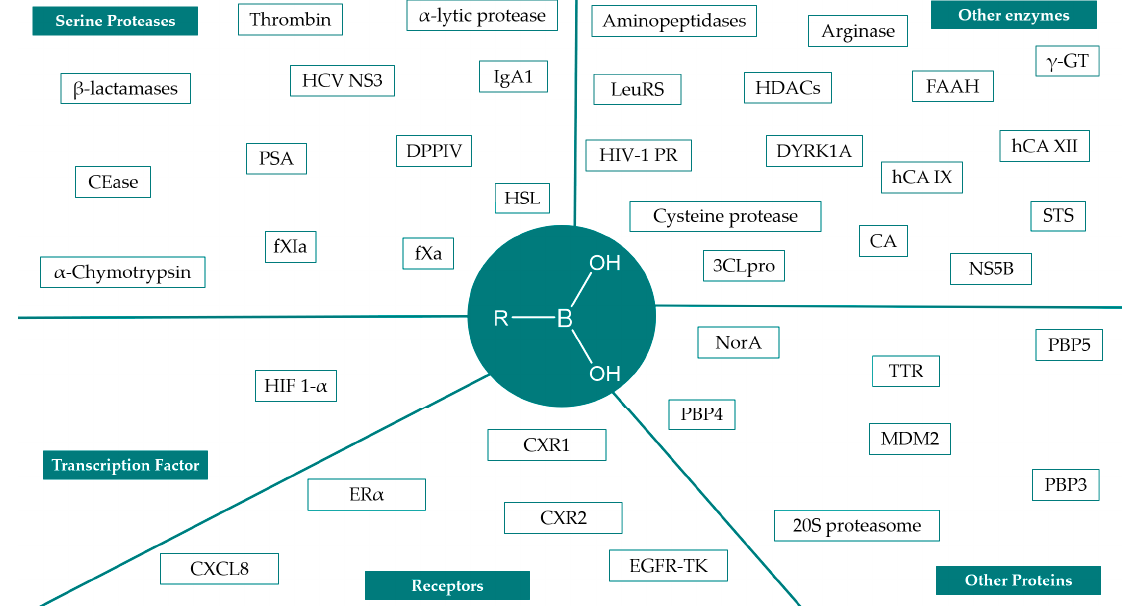
Figure 4. Molecular targets of boronic acids. Serine Proteases include: Dipeptidyl Peptidase IV (DPPIV), Factor Xa (fXa) and XIa, Hepatitis C Virus (HCV) NS3, Hormone ‐ sensitive lipase (HSL), IgA1 protease, Pancreatic cholesterol esterase (CEase), Prostate specific antigen (PSA), Thrombin, α‐ Chymotrypsin, α‐ lytic protease, β‐ lactamases. Other enzymes include: Aminopeptidases, Arginase, human Carbonic anhydrase IX (hCA IX), hCA XII), Cysteine protease, Fatty Acid Amide Hydrolase (FAAH), Histone deacetylases (HDACs), HIV ‐ 1 Protease (HIV ‐ 1 PR), Leucyl ‐ tRNA synthetase (LeuRS), RNA ‐ dependent RNA polymerase NS5B (NS5B), Tyrosine Kinase DYRK1A (DYRK1A), Steroid sulfatase (STS), γ‐ Glutamyl transpeptidase ( γ‐ GT), 3Clike protease (3CLpro). Proteins include: Murine double minute 2 (MDM2), NorA efflux pump (NorA), Penicillin binding protein 3 (PBP3), PBP4, PBP5, Transthyretin (TTR), 20S proteasome. Transcription factors include: Hypoxia ‐ inducible factor 1 ‐α (HIF 1 ‐α ). Receptors include: Chemokine receptors 1 (CXCR1), CXCR2, CXCL8, Epidermal growth factor receptor tyrosine kinase (EGFR ‐ TK), Estrogen Receptor α (ER α ).